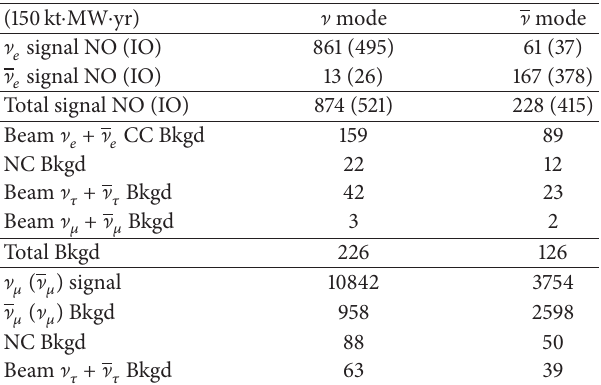
Table 1: Integrated rates of CC-like events. Signal ] 𝑒 rates are shown = 0 . Background rates assume for both NO and IO and 𝛿 CP